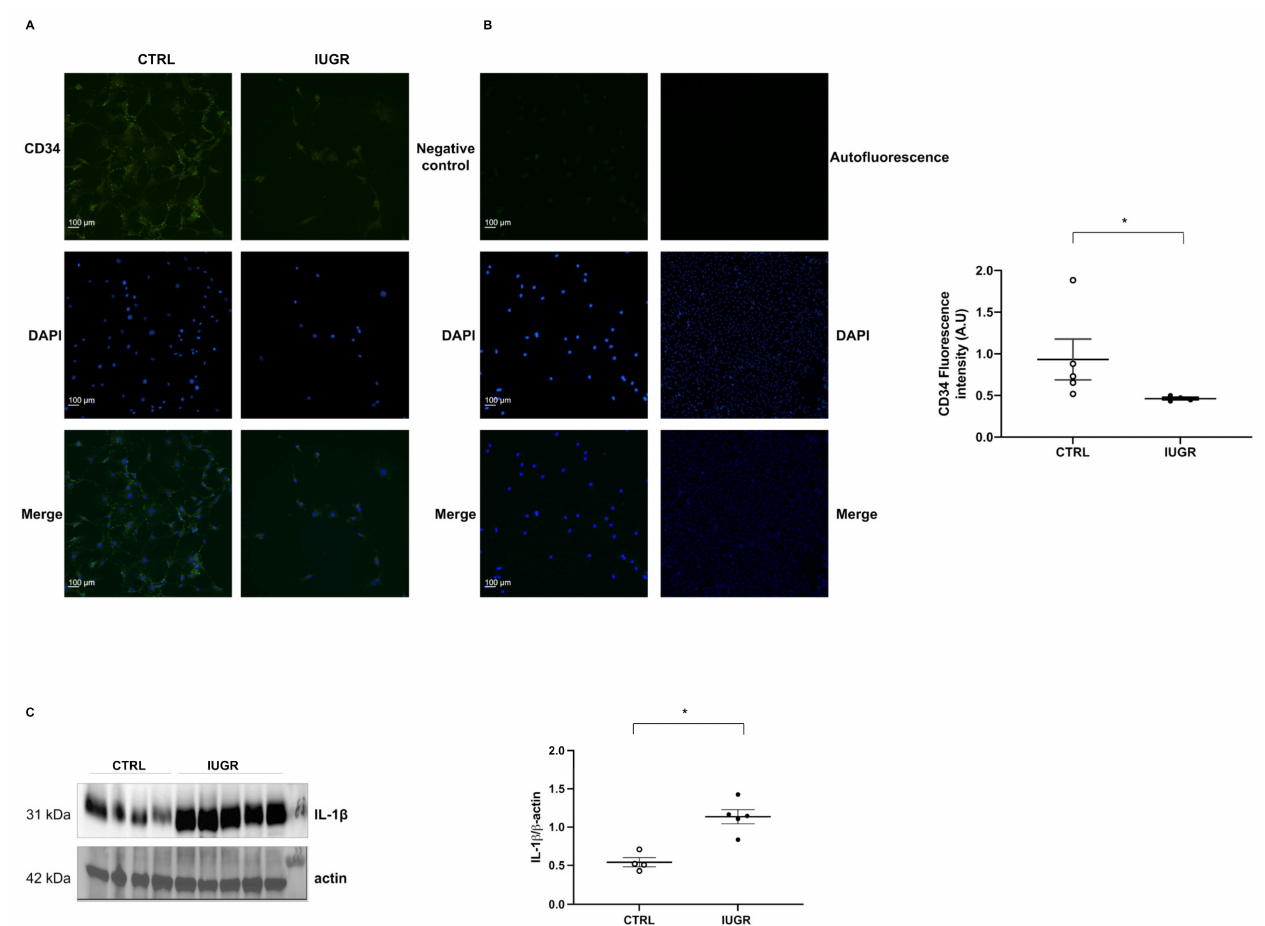
Figure 3. CD34 expression in ECFCs and IL-1 β protein expression. CD34 expression was detected by immunostaining in CTRL-ECFCs and IUGR-ECFCs isolated from six-month-old male rats. Magnification (20 × ). Nuclei were counterstained with DAPI and a negative control (with no primary antibody) and a test for autofluorescence were performed. These pictures are representative images from n = 4–5 animals/group. * p < 0.05 ( A ). Negative control and autofluorescence tests were performed ( B ). Scale bar = 100 µ m. In addition, IL-1 β protein expression was measured in adipose tissue from six-month-old CTRL and IUGR male rats ( C ). n = 3–5 animals/group. * p <